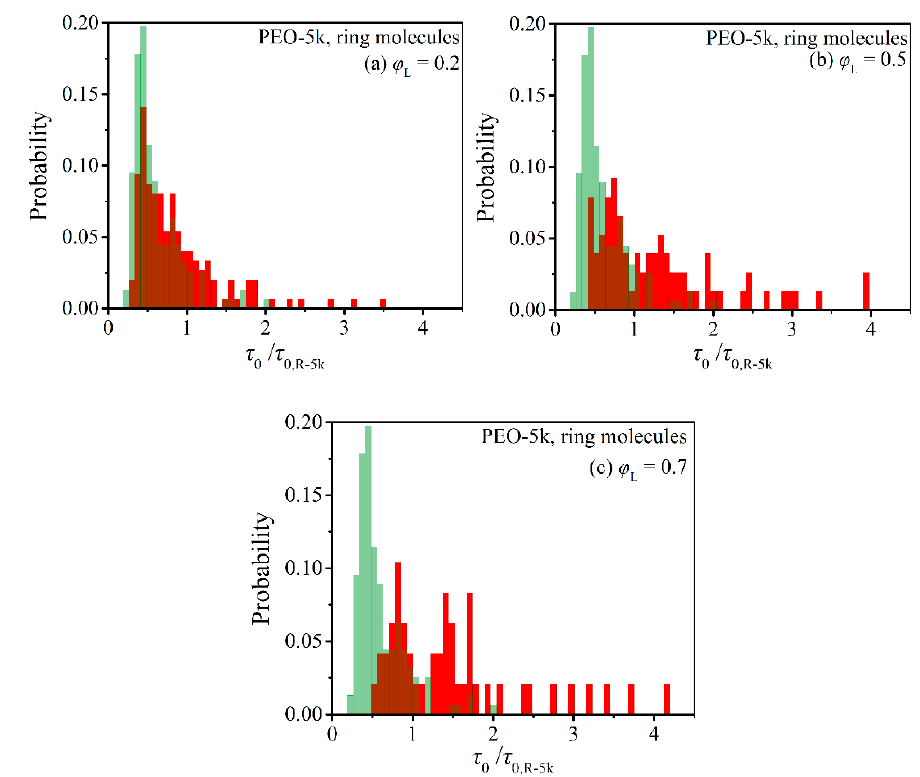
Figure 6. Histograms (red bars) of the characteristic ring orientational relaxation times in the simulated PEO-5k blends as a function of the fraction of linear chains: ( a ) ϕ L = 0.2, ( b ) ϕ L = 0.5, ( c ) ϕ L = 0.7. Green bars represent the corresponding histograms in the pure ring melt from Ref.